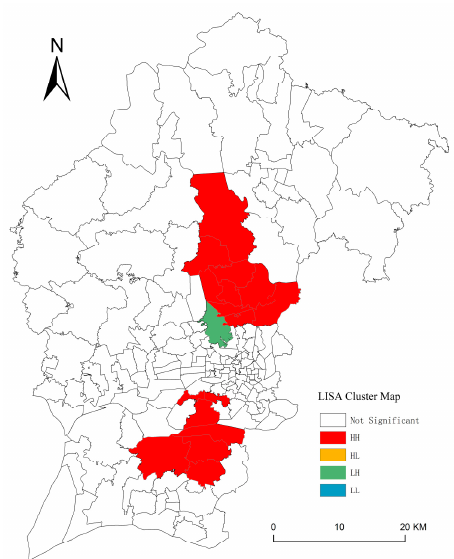
Figure 2. Spatial clusters of residential burglaries during 2013–2015.